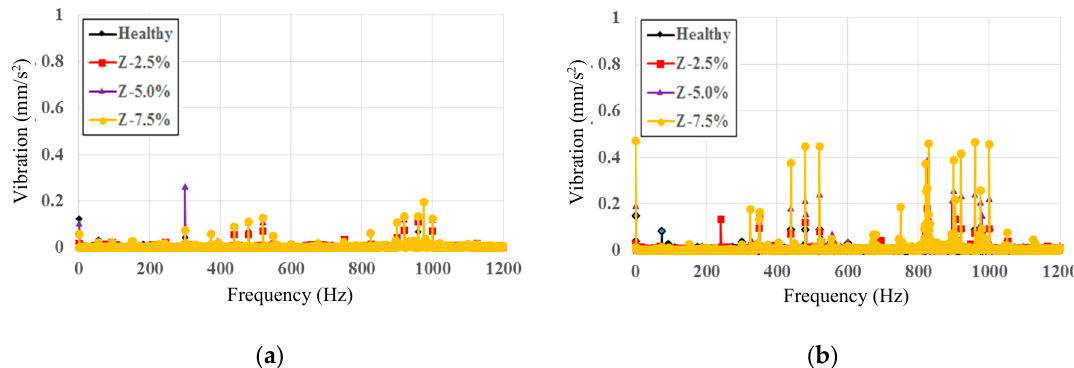
Figure 8. FFT analysis of measured vibration waveforms emitted from the motor with axial demagnetization: ( a ) no load torque; ( b ) 70% load torque.